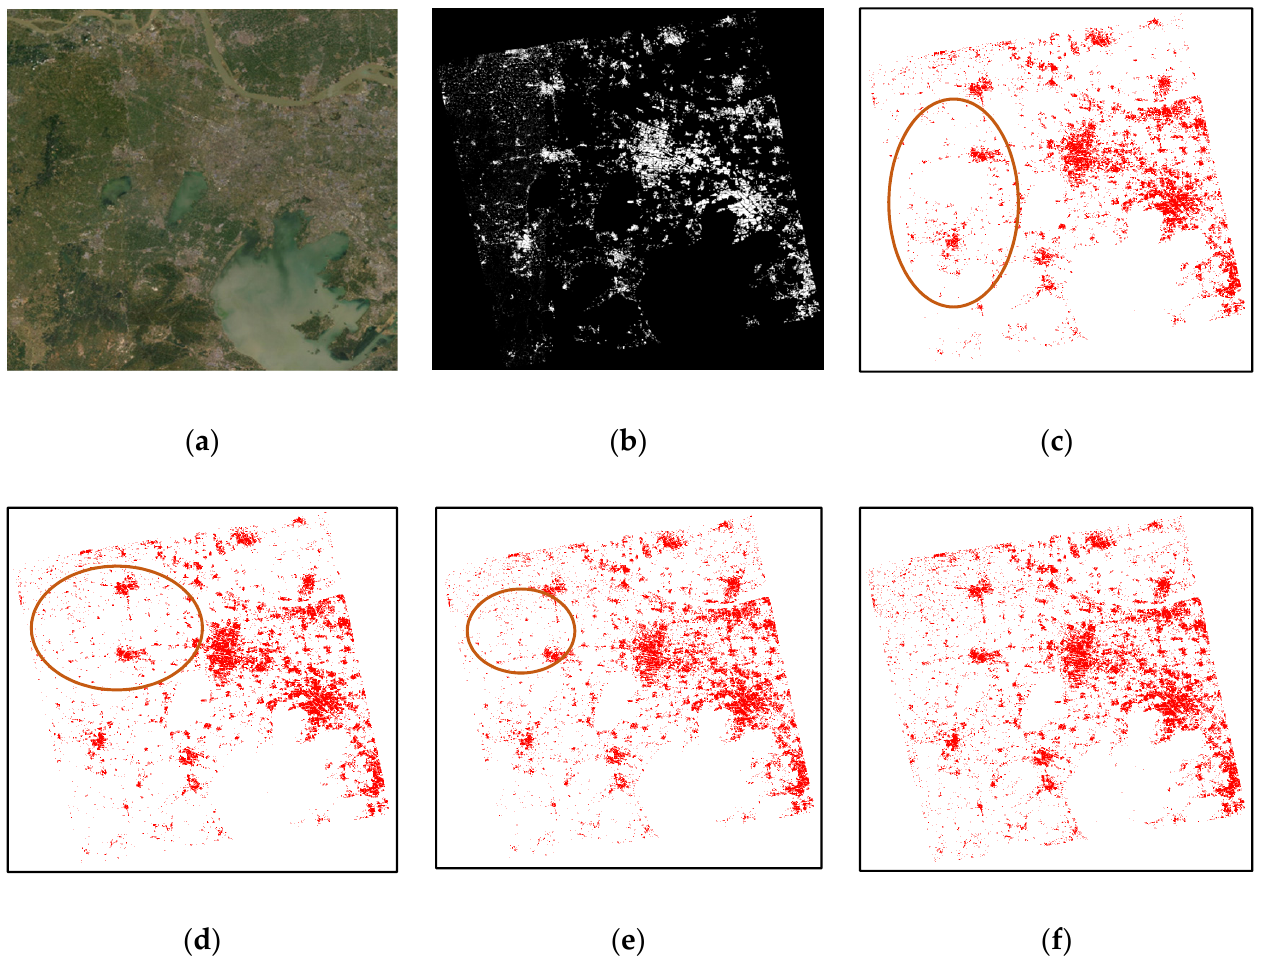
Figure 8. The BA results in T1: ( a ) Google Earth image, ( b ) ground truth, and ( c – f ) results based on UNet, PSPNet, SegFormer, and the proposed model. The blue box marks the false alarms.